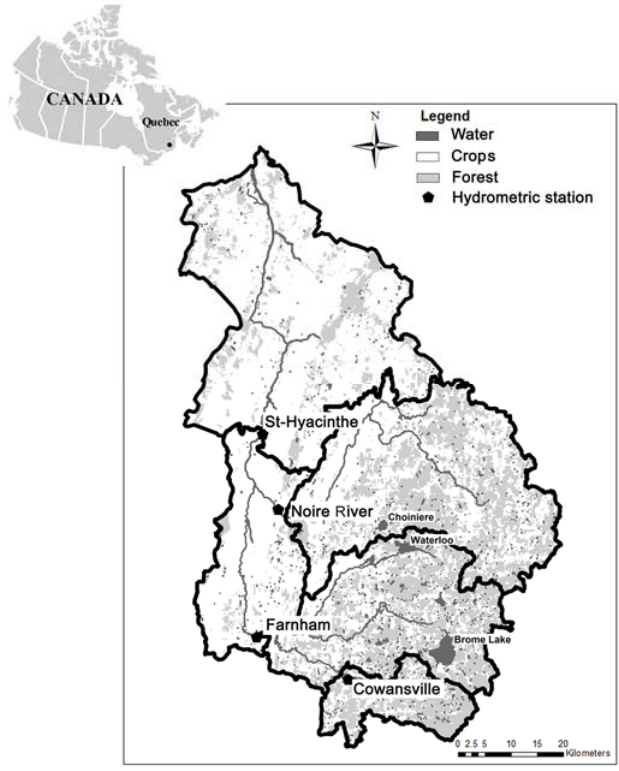
Figure 1. Yamaska River watershed.